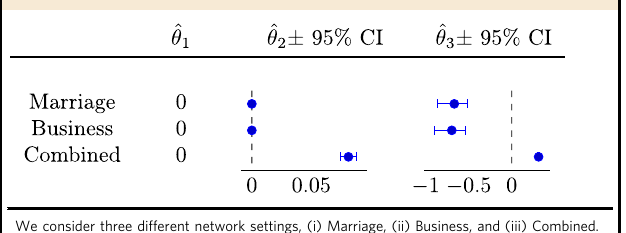
Table 1 Results of the Medici ’ s behavior estimate.